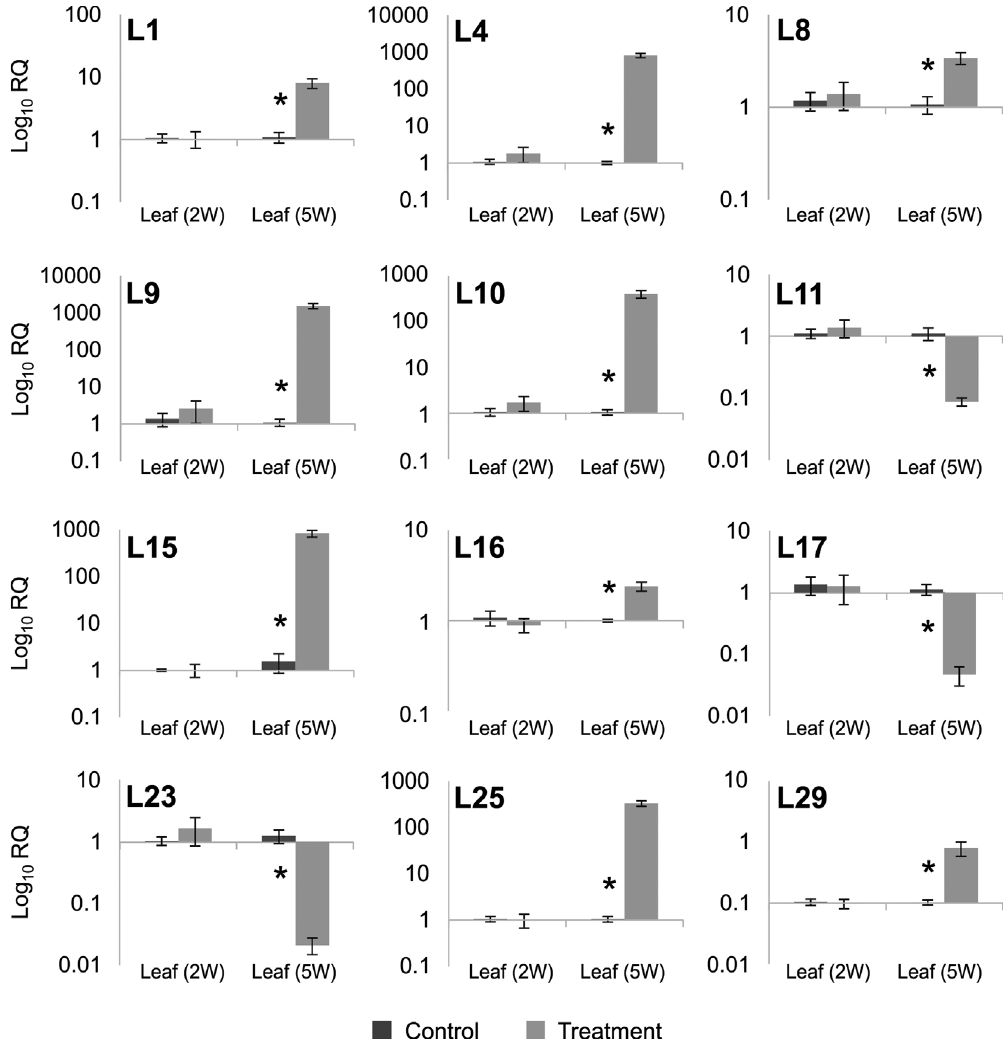
Figure 3 - RT-qPCR analysis of selected leaf transcripts. Expression is shown for the 12 transcripts that were validated by RT-qPCR. Wheat leaves were sampled from two week-old (2 W) plants, where control plants were irrigated at 100% of field capacity (FC) and treated plants were irrigated at 75% FC. Five-week-old (5 W) plants are represented by control plants irrigated at 100% FC, and treated plants, where irrigation was withdrawn for three weeks. The experiment was performed in triplicate biological samples, with technical triplicates for each. Relative expression was calculated by the 2 - (cid:4)(cid:4) ct method. Asterisks represent significantly different (Student’s t- test, p (cid:5) 0.05) transcript levels. For more details on primers see Table 2 and Table